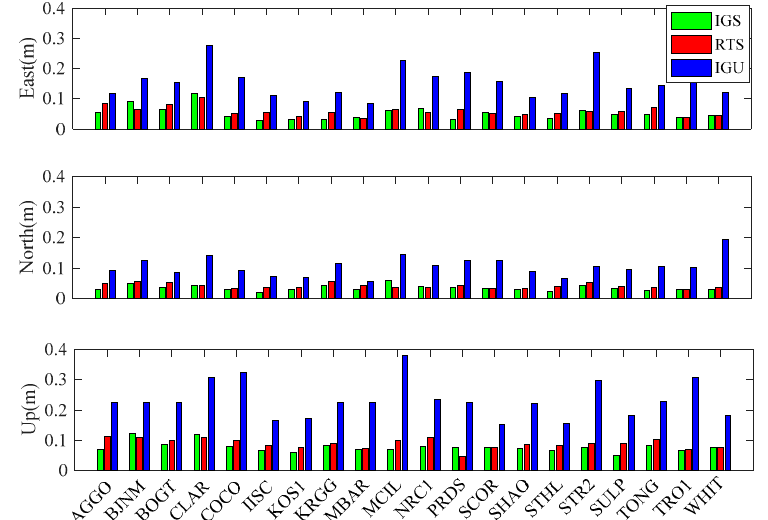
Figure 6. Kinematic precise point positioning (PPP) solutions using the RTS products (red), the IGS ultra-rapid (IGU) products (blue) and the IGS products (green) at station KOS1 ( a ) and SHAO ( b ) on 19 October 2017.